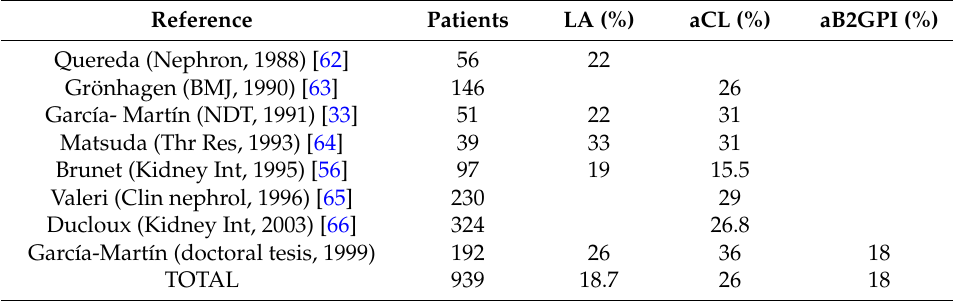
Table 1. Prevalence of consensus aPL in hemodialysis